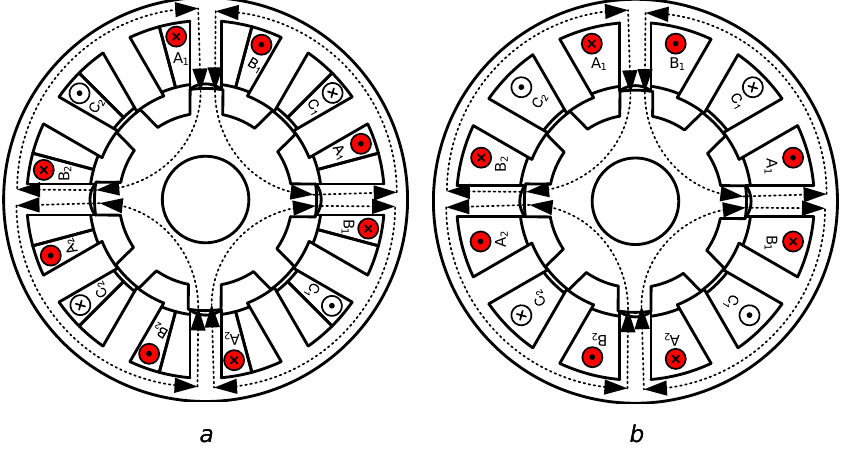
Figure 2. Winding arrangement for double-phase excitation; ( a ) fully-pitched winding 1 and ( b ) fully- pitched winding